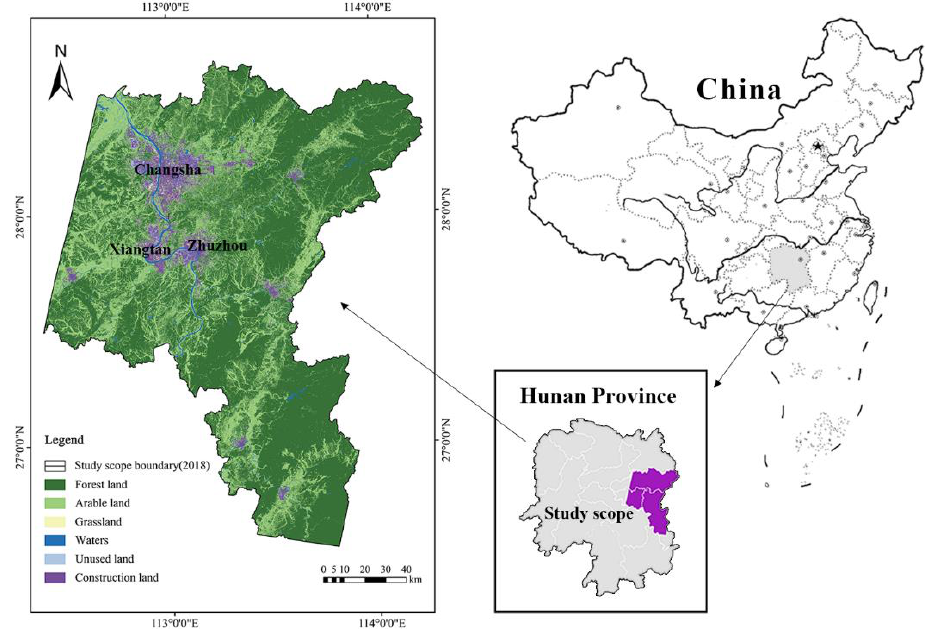
Figure 1. Location of the study area and its land-use map in 2018.